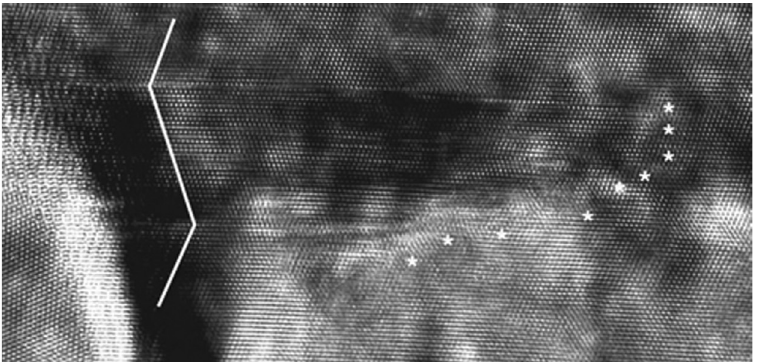
Figure 5 A high-resolution transmission electron microscopy image of a twin formed by plastically deforming electrodeposited nanocrystalline